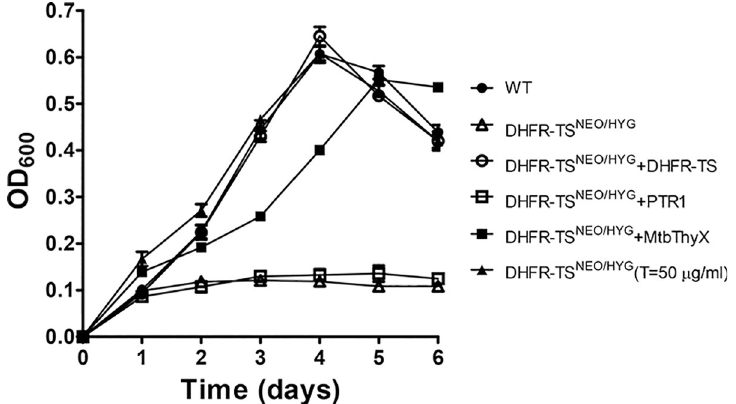
Fig 4. Metabolic and genetic complementation of the DHFR-TS null mutant. Cells were grown in SDM-79 medium and their growth was monitored by measuring their OD at 600 nm. L . infantum wild-type cells ( ● ); or L . infantum DHFR-TS NEO/HYG complemented with either psp72 α blast α -DHFR-TS ( � ), psp72 α blast α -ThyX( ■ ); psp72 α blast α - PTR1 ( ☐ ); or supplemented with 50 μ g/ml thymidine ( ▲ ); or no supplementation at all ( 4 ). Average of three experiments with standard error of mean (SEM) are